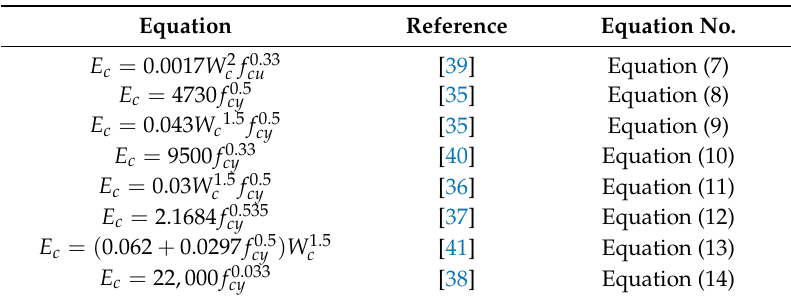
Table 7. Practical Equations for Elastic Modulus of